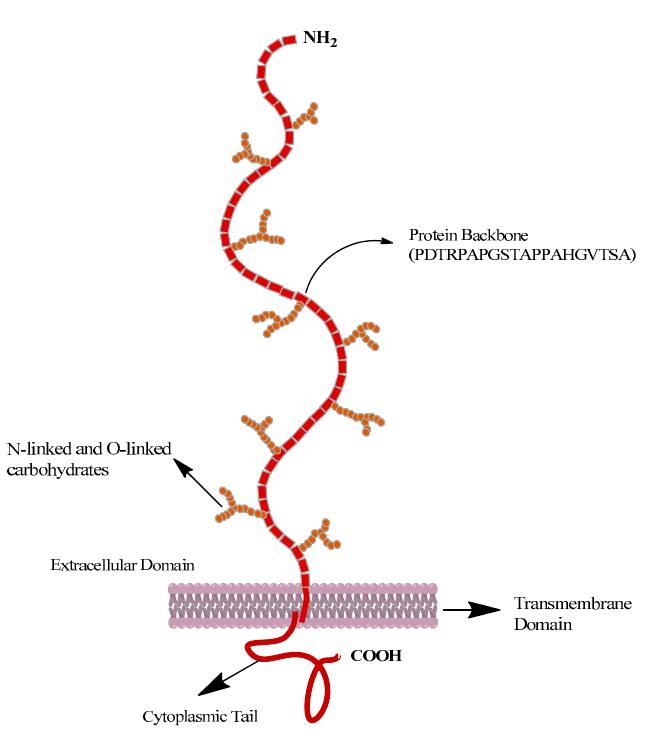
Figure 2. Structure of mucin 1 (MUC 1) [38].